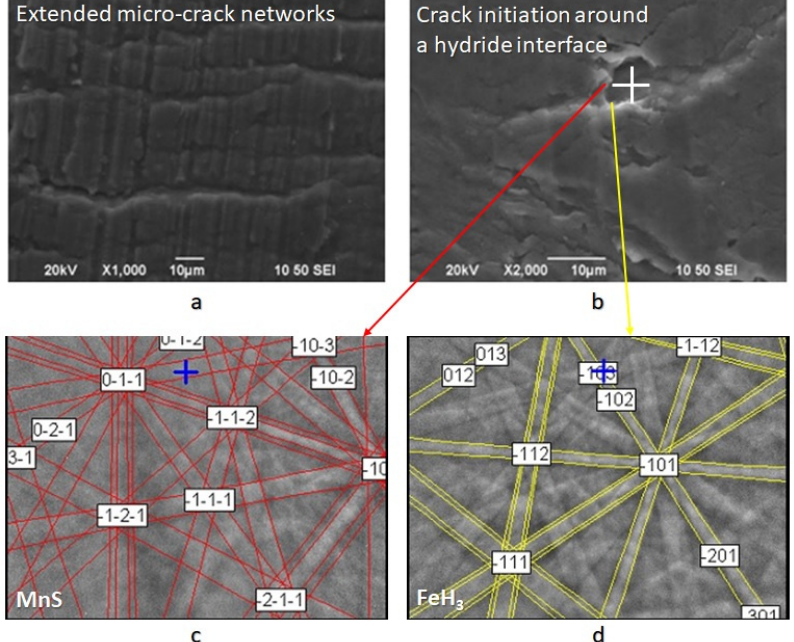
Figure 8. ( a ) Stepwise micro-cracking and micro-cracking branching, ( b ) crack initiation points at hydride / non-metalic inclusion interfaces, ( c , d ) identification of a non metallic inclusion at a high bridge formation from Electron Backscatter Diffraction technique (EBSD).